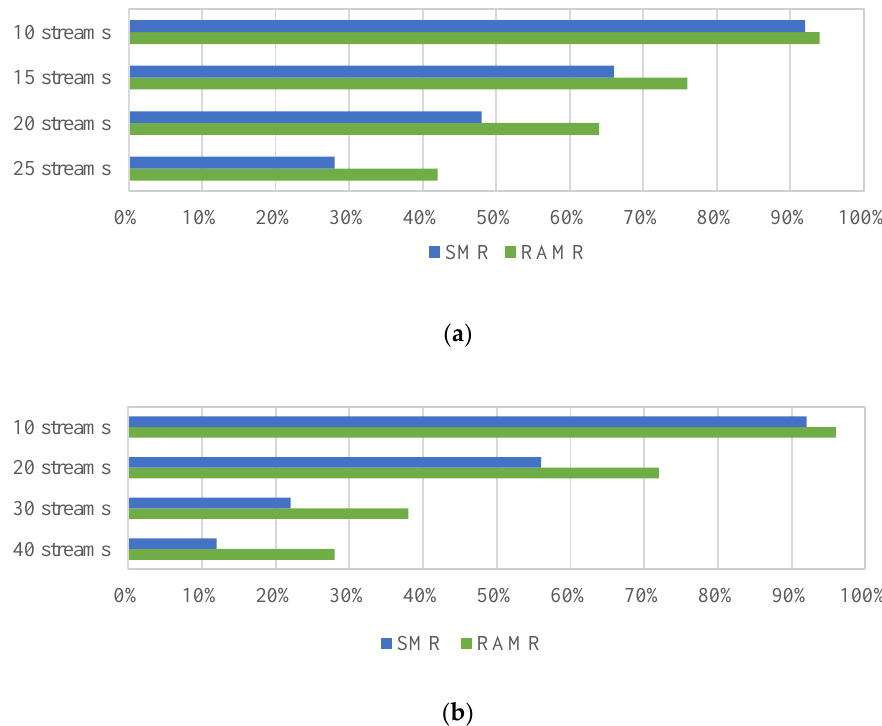
Figure 13. The average success rate of schedule among 50 test cases for varying load in: ( a ) Topology 2; ( b ) Topology 3.